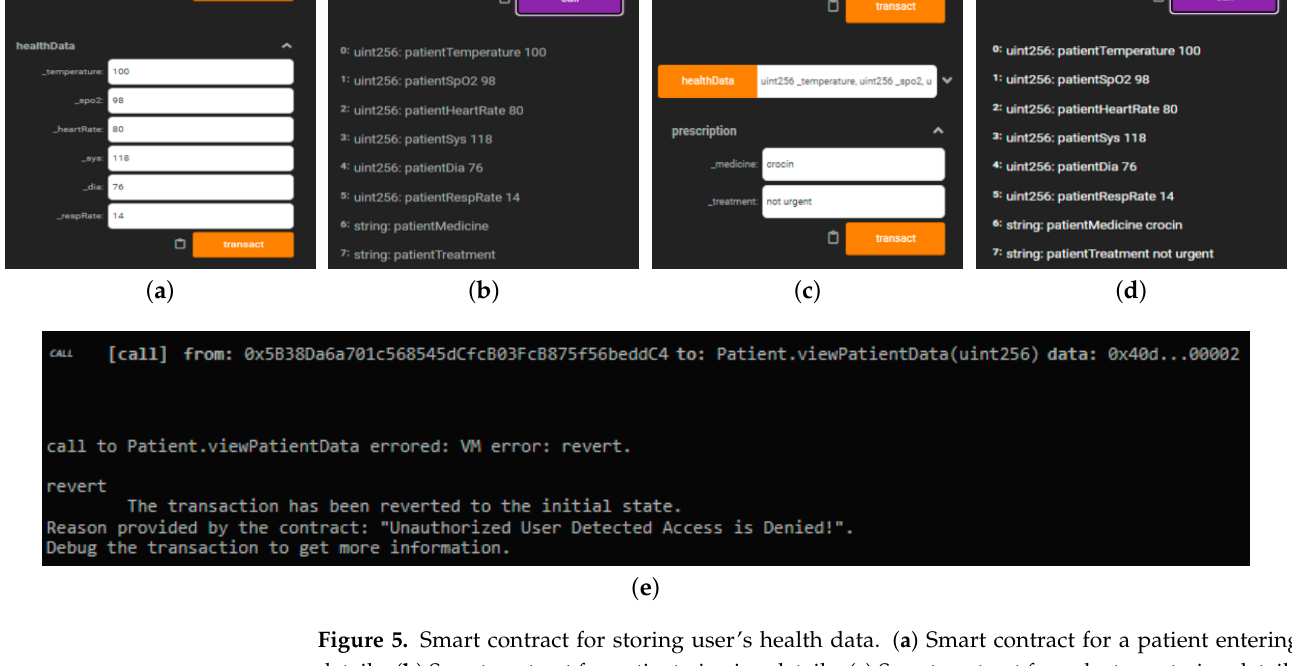
Figure 5. Smart contract for storing user’s health data. ( a ) Smart contract for a patient entering details. ( b ) Smart contract for patient viewing details. ( c ) Smart contract for a doctor entering details. ( d ) Smart contract for a doctor viewing details. ( e ) Warning message when an unauthorized user tries to access patient